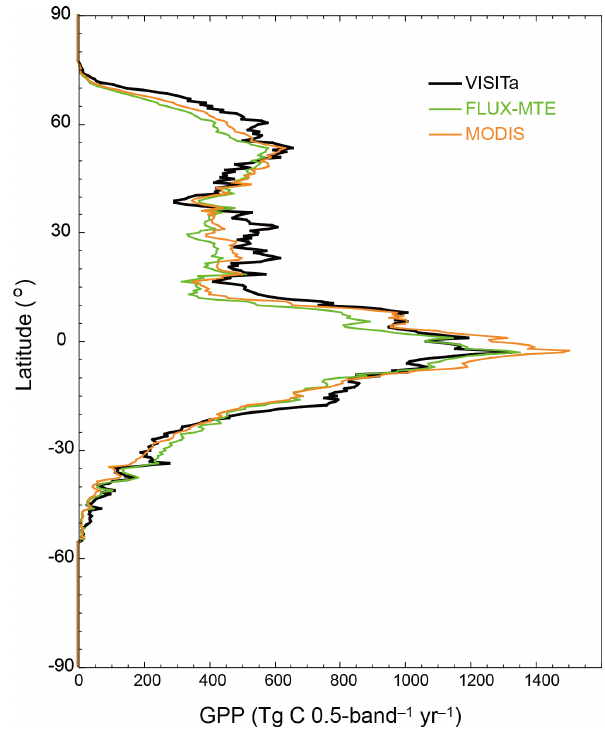
Figure 6. Comparison of latitudinal distribution of gross primary production (GPP) in 2000–2010 with upscaled flux measurements (Model-Tree Ensemble (MTE); Beer et al., 2010) and satellite ob- servation (MODIS; Zhao et al.,